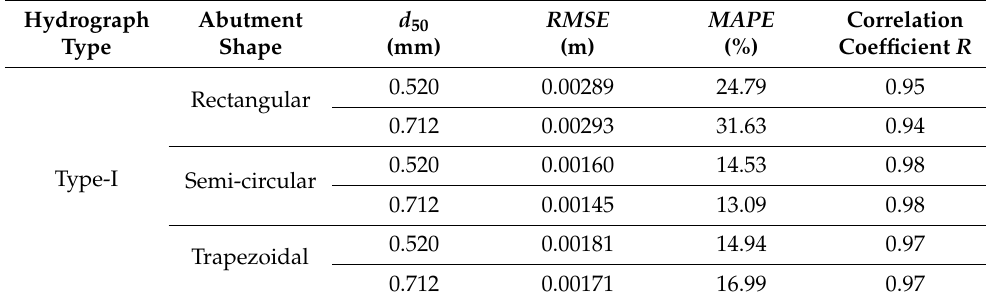
Table 5. Statistical results for the scour-depth performance of the proposed model.